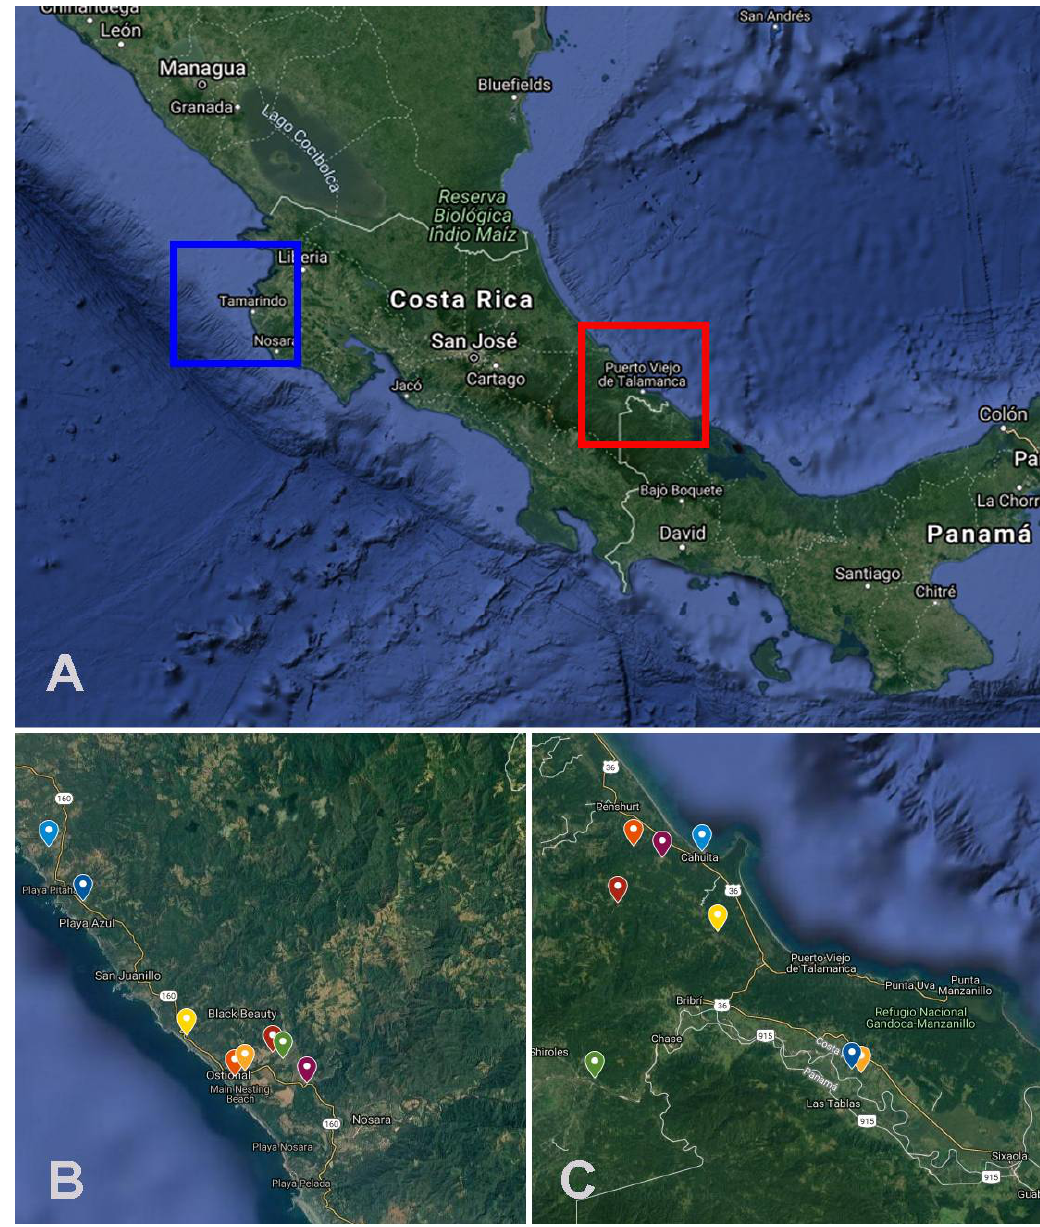
Figure 1. ( A ) Geographic locations of the sampling sites in Costa Rica, the squares indicate Santa Cruz (Northern Pacific) (10°16′00″ N, 85°39′00″ W) and Talamanca (Southern Caribbean) (09°44’28″ N, 82°50’46″ W). ( B , C ) Each sampling unit is highlighted in these two regions. Maps Source: Map data ©2021 Imagery ©2021 TerraMetrics and CNES/ Airbus, Lansat/Copernicus, Maxar Technolo- gies, US Geological Survey from GoogleMaps.